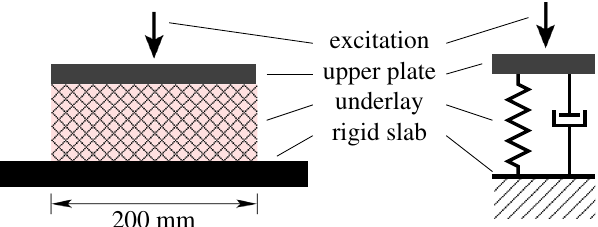
Figure 1. Schematic setup (left) and mechanical analogy (right) of an experimental setup according to